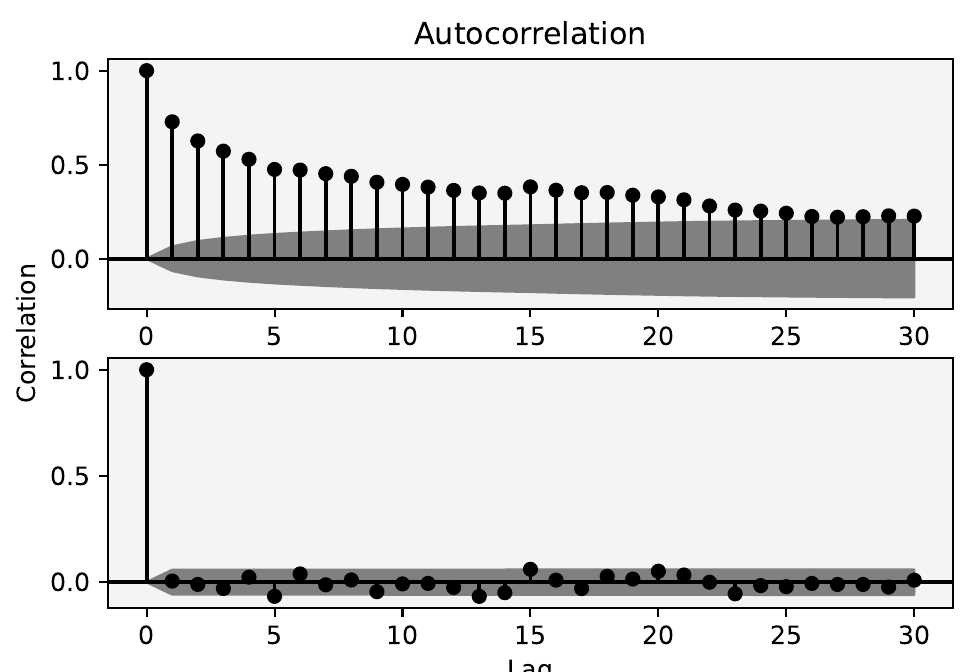
Figure 2. Autocorrelation functions of time series transformation with d = opt (upper one) and d = 1 (lower